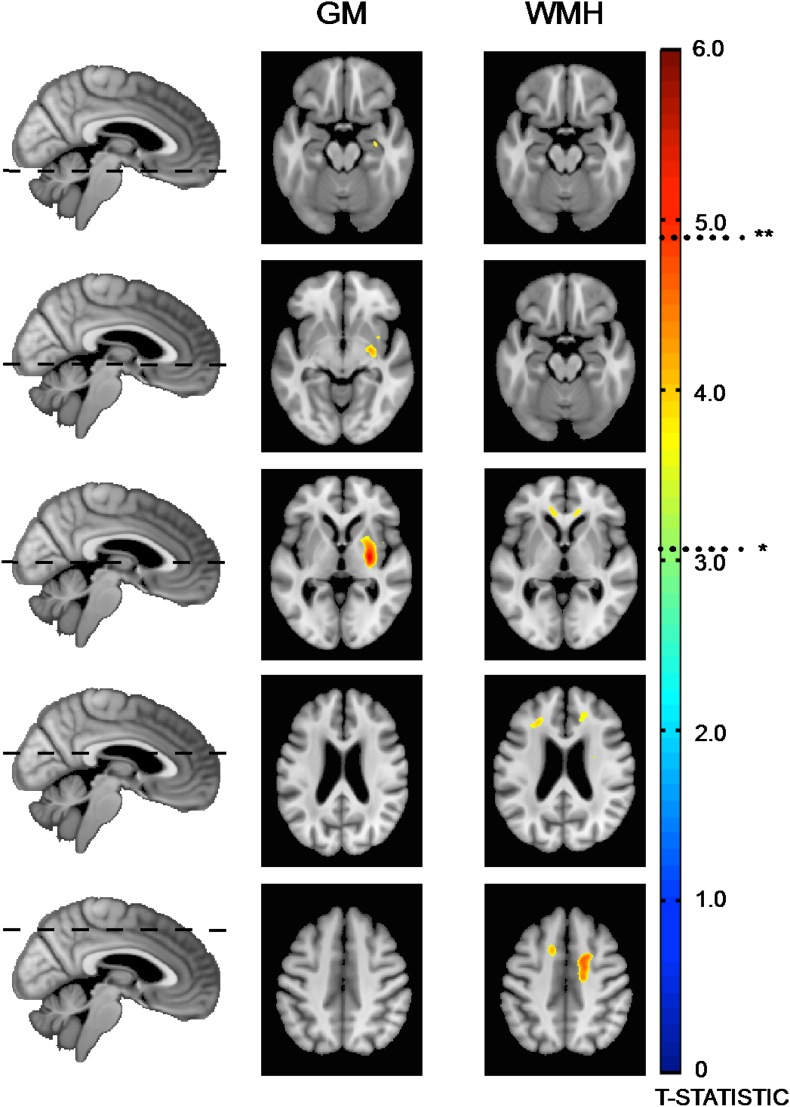
Voxel-based morphometry regions of decrease GM density and increased white-matter hyperintensities between the preclinical dementia and normal patient cohorts. *P < 0.001 uncorrected, **P < 0.05 FWE corrected.